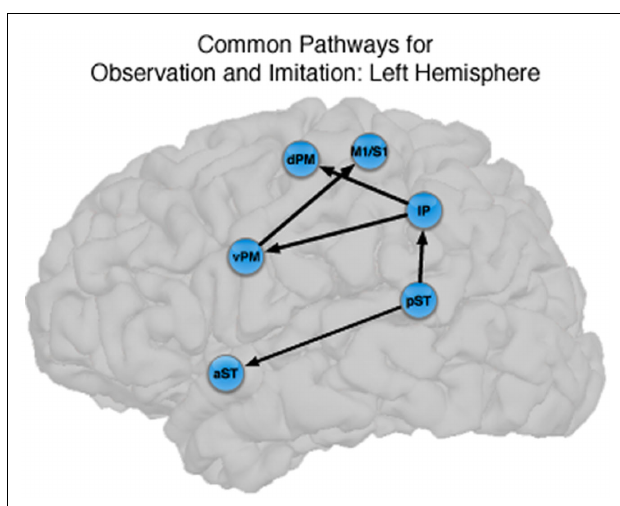
FIGURE 3 | Comparison between the models of observation and imitation in LH and in the RH. The connections between pST, aST, IP, vPM, dPM, and M1S1 showing stronger connection weights for Imitation vs Observation, and stronger connection